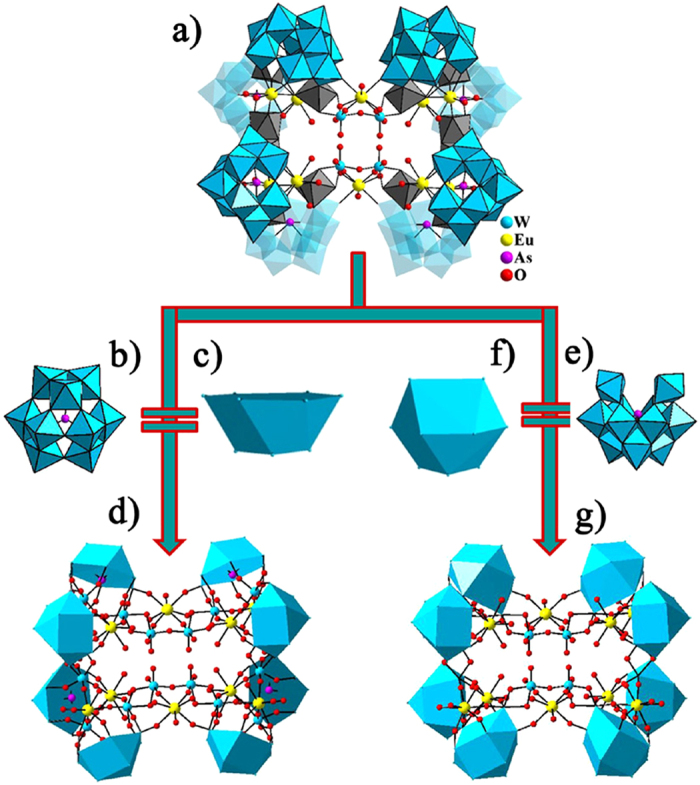
(a) The molecular structural unit of 1a. (b) The
[B-α-AsW9O33]9−
segment. (c) The simplified polyhedron of the
[B-α-AsW9O33]9−
segment. (d) The simplified model of 1a. (e) The
[B-α-AsW11O41]13−
segment. (f) The simplified polyhedron of the
[B-α-AsW11O41]13−
segment. (g) The simplified mode of 1a.